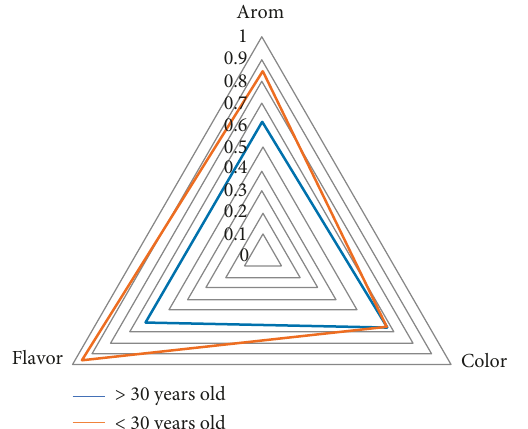
Figure 5: Sensory evaluation of grape kombucha by two age groups of